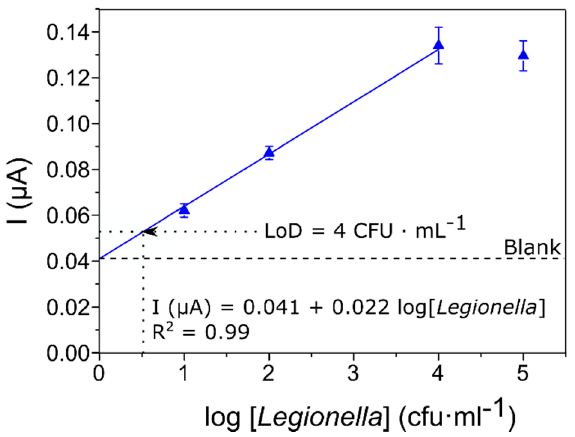
Figure 4. Sensor calibration curve, where the current obtained at a constant potential of 50 mV after 50 s of the chronoamperometry is expressed in absolute values as a function of the logarithm of the increasing concentrations of Legionella from 0 (blank) to 10 5 cfu · mL − 1 . The regression line is indicated in blue and error bars represent the standard error ( n = 6).